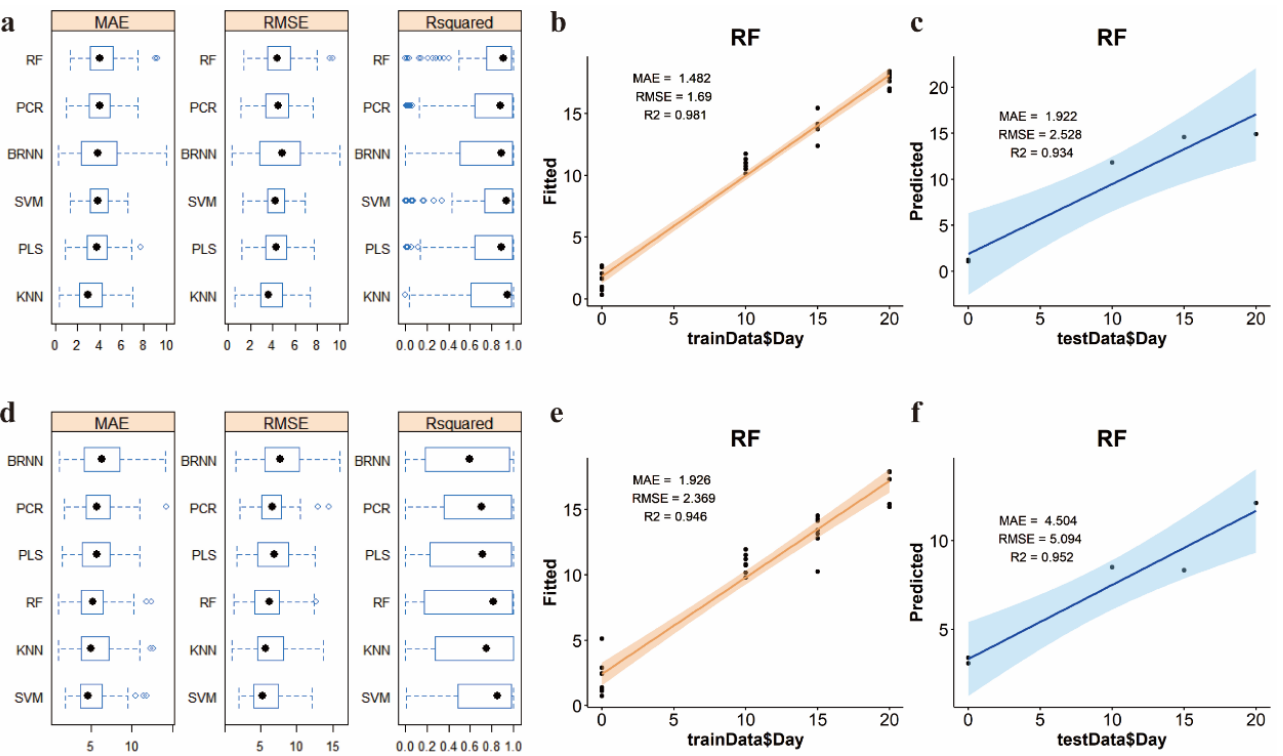
Figure 4. The training and testing results of six machine learning models. ( a ) The box diagram of training results of 6 machine learning models of serum. ( b ) The training results of the RF model of serum. ( c ) The time prediction results of the RF model of serum in the testing set. ( d ) The box dia- gram of training results of 6 machine learning models of urine. ( e ) The training results of the RF model of urine. ( f ) The time prediction results of the RF model of urine in the testing set.